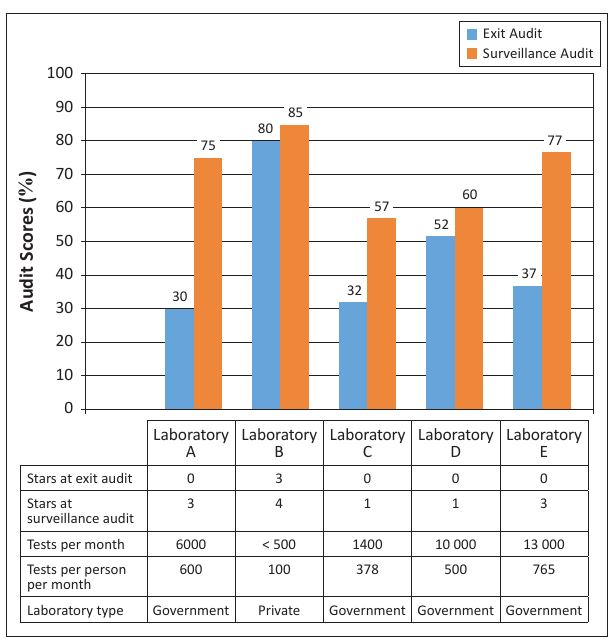
FIGURE 1: Performance of the five laboratories based on Stepwise Laboratory Quality Improvement Process Towards Accreditation (SLIPTA) checklist scores and star